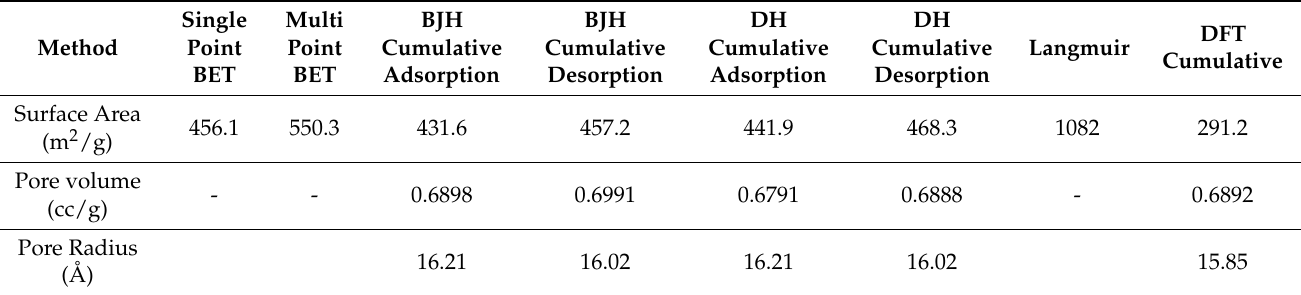
Table 1. Surface area, pore volume, and pore radius of rGO-ZnS-Ag